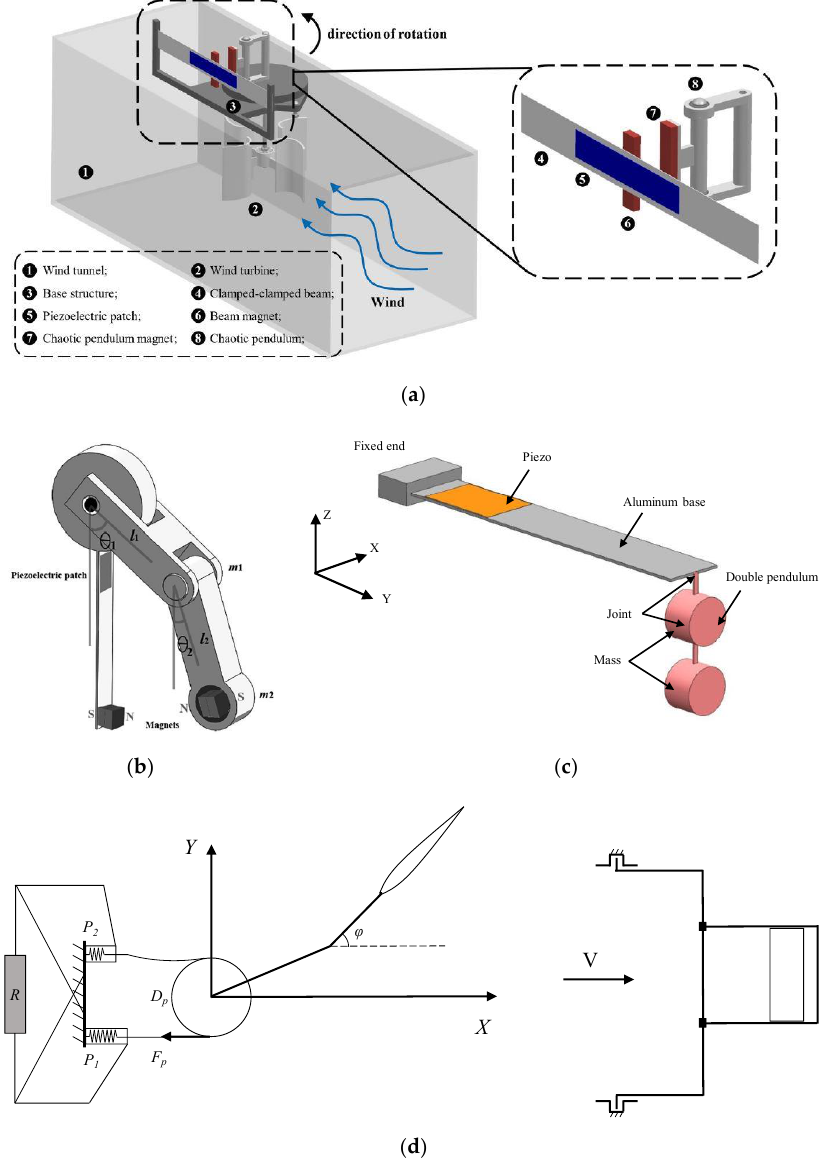
Figure 18. ( a ) Rotational wind energy harvester based on magnetic double pendulum [119]. ( b ) Double-pendulum energy harvester applied in human motion energy conversion [120]. Reprinted with permission from Ref. [120]. Copyright 2019, Elsevier. ( c ) Piezoelectric cantilever beam coupled with double pendulum [121]. ( d ) Flow-induced vibration energy harvester based on double aerodynamic pendulum [122].